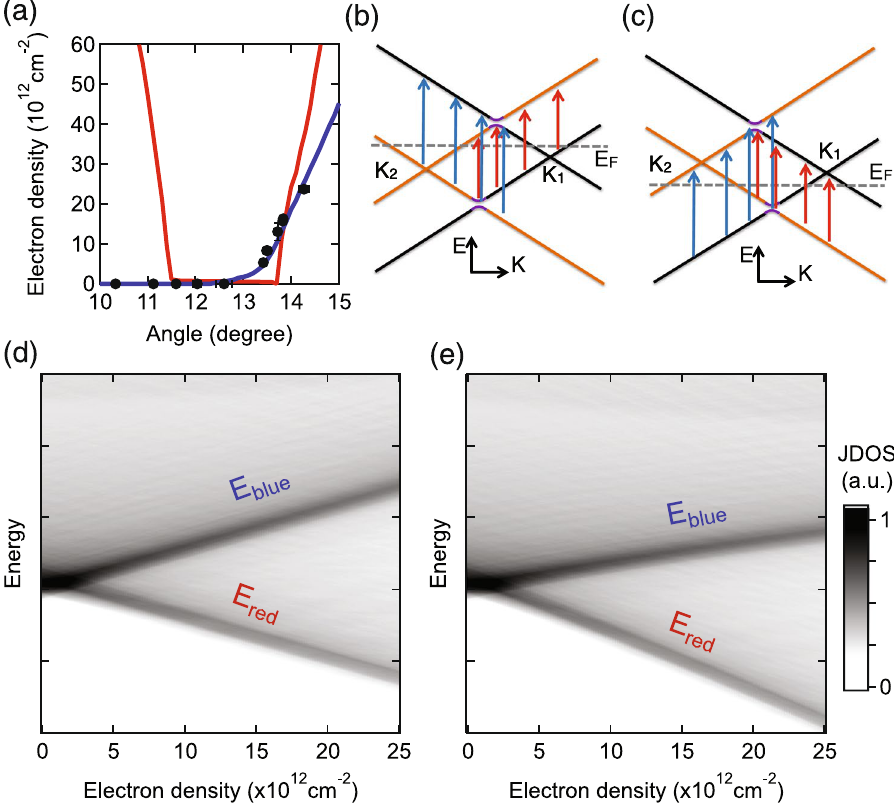
Figure 4. ( a ) Charge density for the maximum G peak area versus twist angle. The red line is the calculation considering only the interlayer potential imposed by the asymmetric doping in the two layers. The blue line is the calculation including the reduction of Fermi velocity as discussed in the text. ( b ),( c ) Electronic band structure evolution upon doping of tBLG with electrons and holes respectively. Orange and black Dirac cones are from the top and bottom layers respectively. ( d ),( e ) JDOS as a function of energy and charge density for ( d ) only an interlayer potential and ( e ) an interlayer potential and a reduction of the Fermi